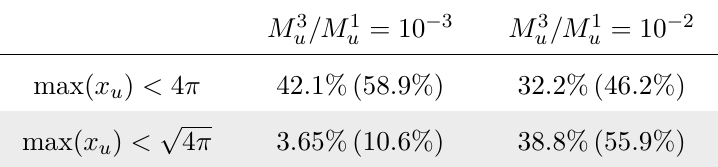
= 1 . The numbers in parentheses are duu = ¯ f 23 = 1 . The parameter sets are restricted by the √ duu duu 4 π . Here, f M = f M d = M 1 u = M 2 u